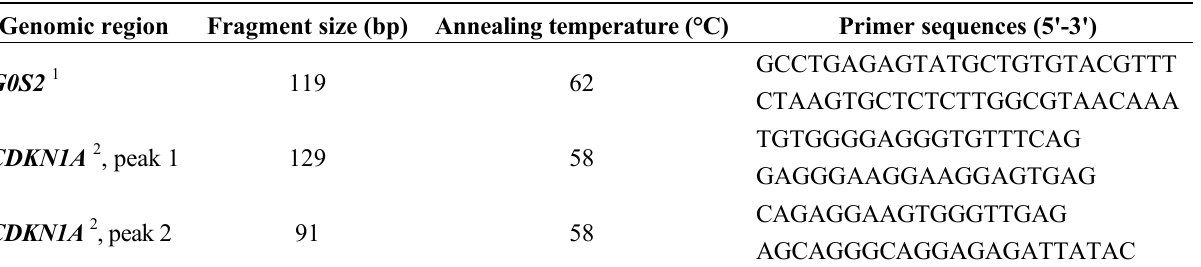
Table S2. ChIP-qPCR